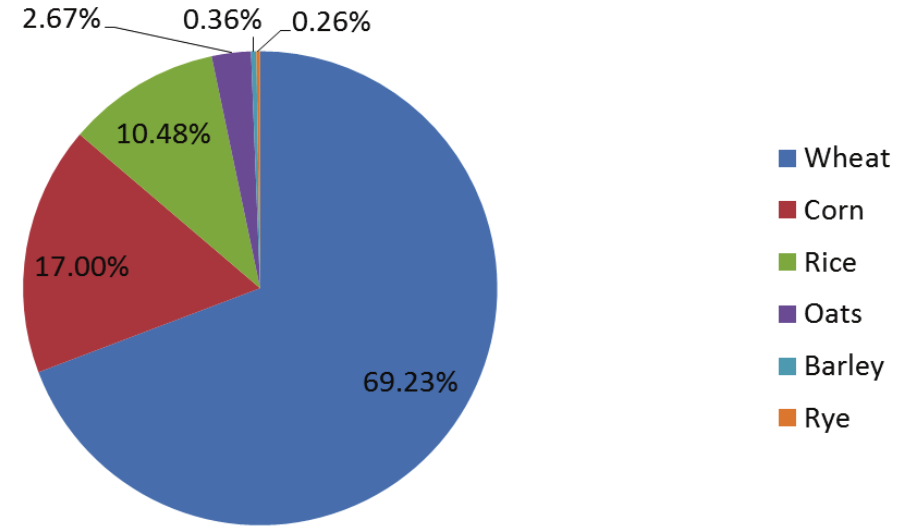
Figure 1. Percent of per capita availability of cereal grains in the United States. Data from the USDA Economic Research Service, 2012